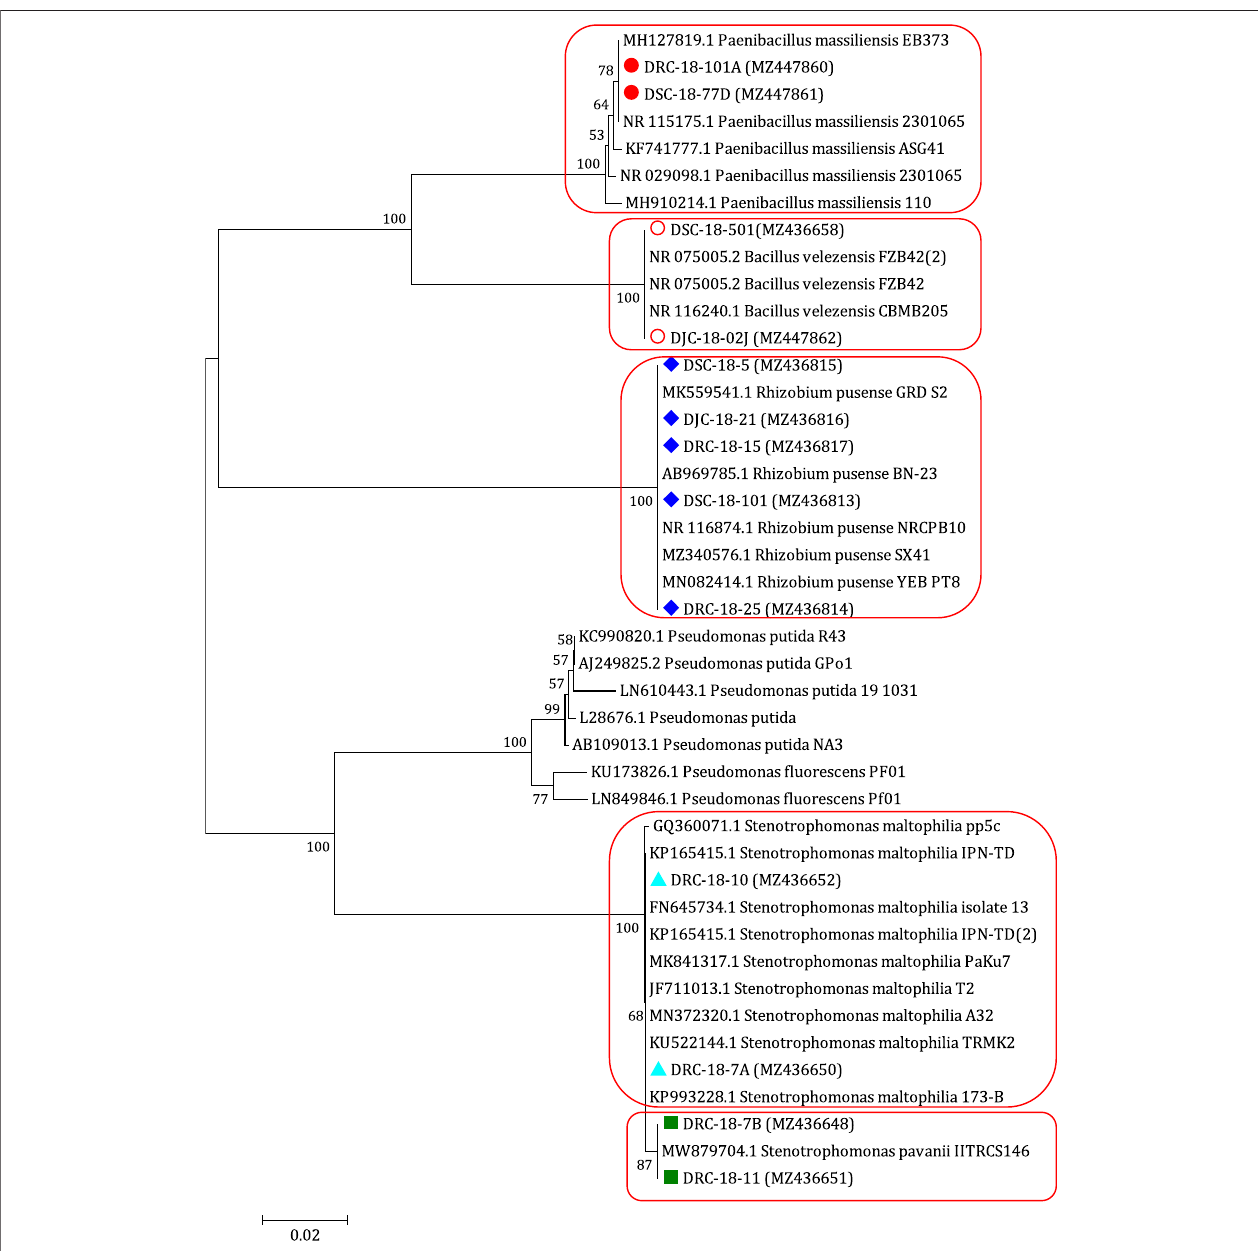
FIGURE 2 | Neighbour joining tree derived by CLUSTAL W and MEGA X using analysis of 16S rRNA gene sequences of bacterial strains isolated from coal mines. The numbers at nodes indicate bootstrap support values, as calculated by MEGA X.